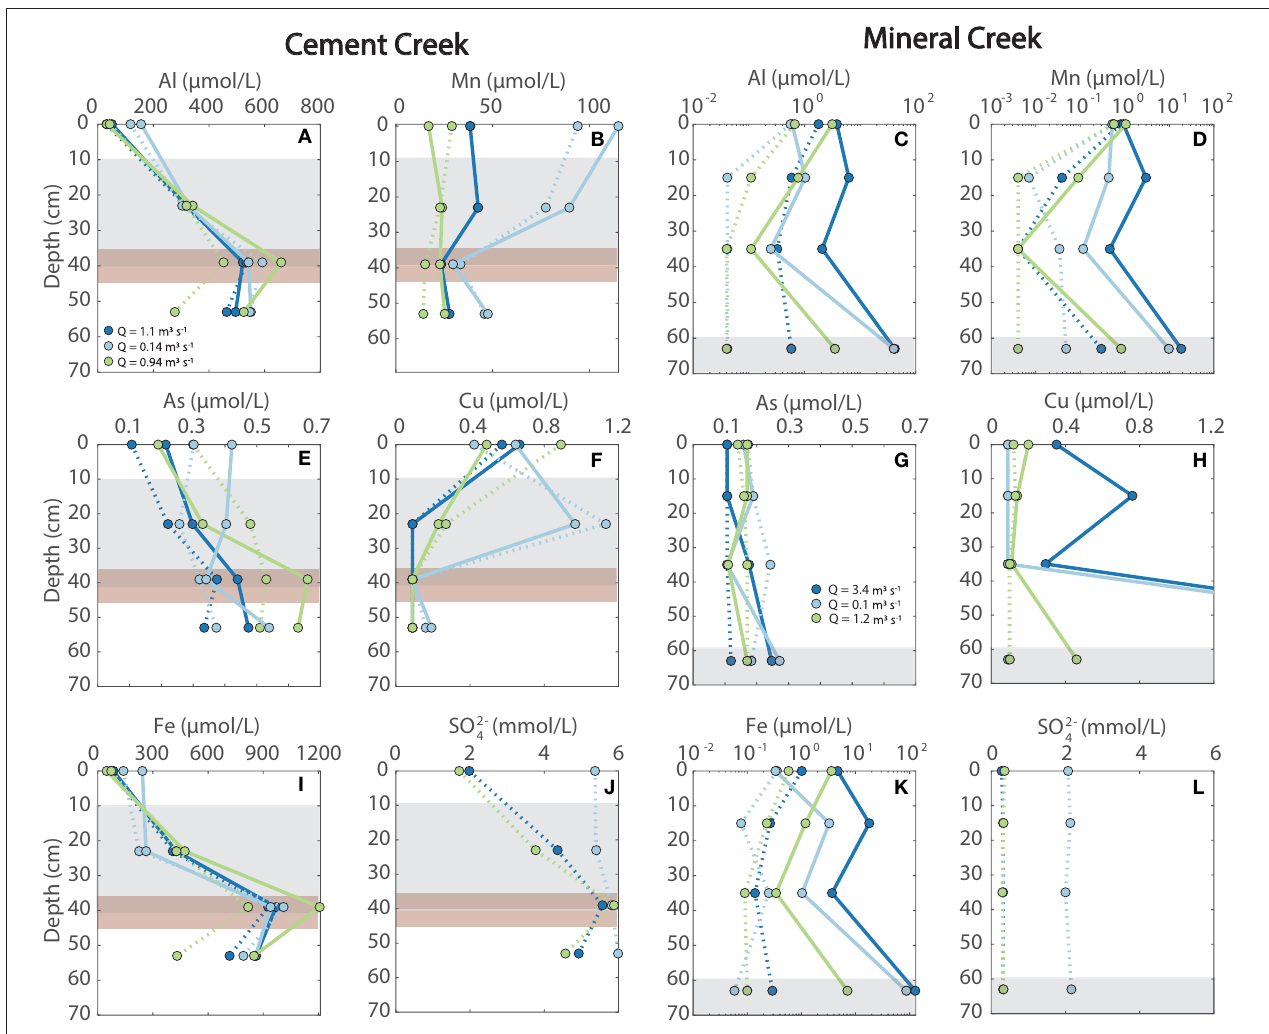
FIGURE 5 | Hyporheic zone chemistry in the CC-PG (A,B,E,F,I,J) and MC-Fen (C,D,G,H,K,L) well clusters. The colors represent different sampling events and associated stream discharge ( Q ), the dashed lines represent dissolved ( < 0.2 µ m) concentrations, and the solid lines represent total metal(loid) concentrations (e.g., unfiltered). Note the difference in x-axis range for the Al, Mn, and Fe subplots for Mineral Creek. The deepest data points on the Cement Creek plots represent shallow groundwater chemistry sampled from a nearby well ( Figure 1D ). The shaded red bar represents the low hydraulic conductivity barrier between groundwater and hyporheic mixing zone. The gray-shaded regions represent the range of the hyporheic extent (relative to ground surface) modeled in one-dimensional transport with inflow and storage. The white area from 0cm to the top of the gray-shaded area represents the hyporheic extent at low flow and the gray-shaded area represents the hyporheic extent at high flow, where the hyporheic extent at high flow for Mineral Creek extends off the plot to a depth of 180cm. The arrows in (D,H) represent total Cu concentrations at 68-cm depth in Mineral Creek (corresponding data in Supplementary Table 5